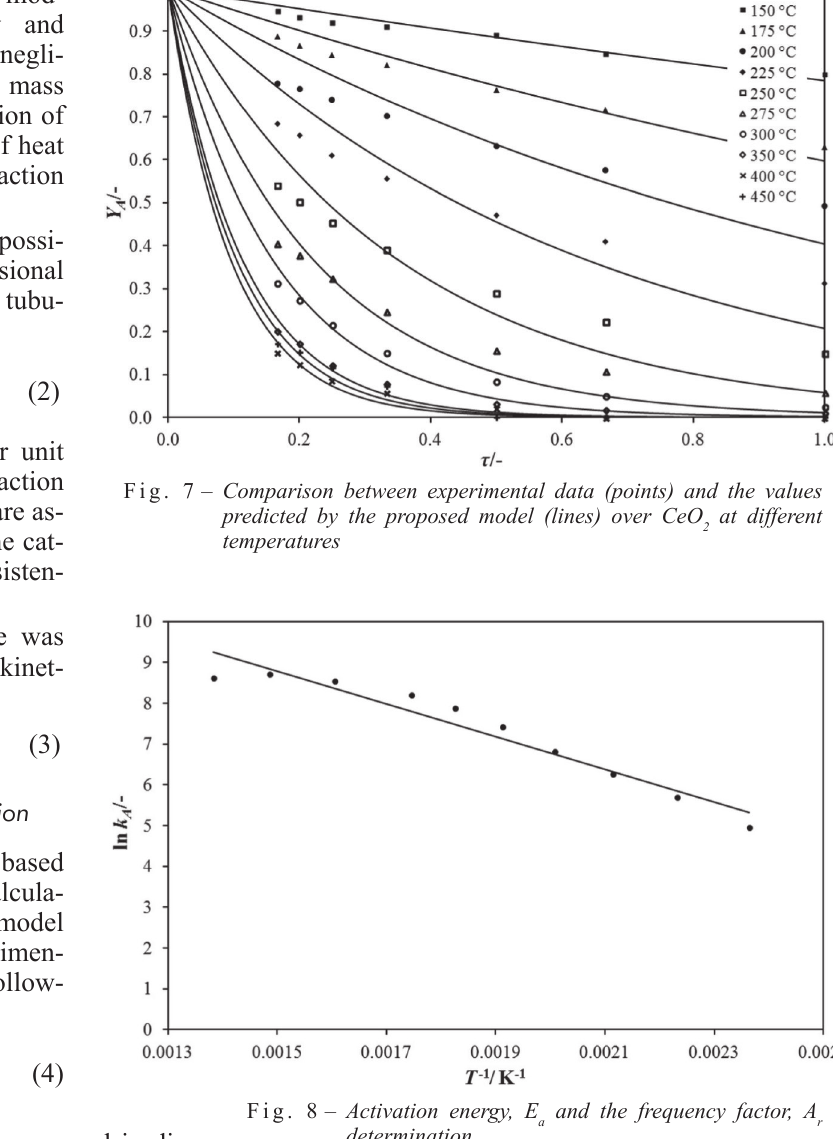
Fig. 8 – Activation energy, E